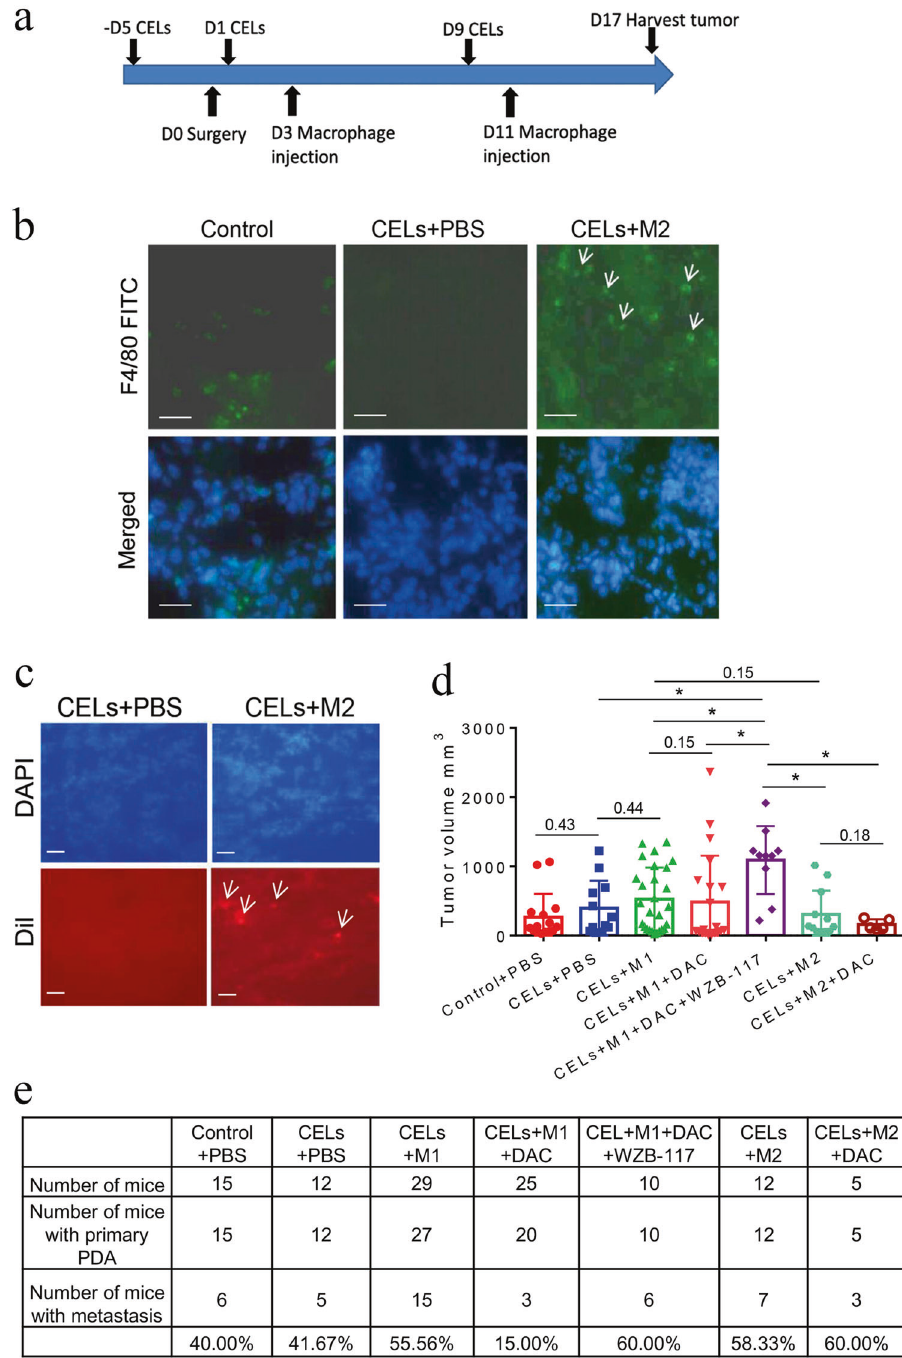
Fig. 5 Tumor-educated macrophages promote metastasis in the “ orthotopic ” mouse model of PDA in a DNA methylation-dependent manner. a Scheme of the experiment. The exogenous macrophages were isolated from eight C57BL/6 mice. b Pancreas tissues were stained with FITC- conjugated anti-F4/80 antibody to evaluate macrophage depletion and exogenous macrophage infusion. Representative treatment groups are shown. Arrow indicates F4/80-positive macrophages. Scale bar: 50 μ m. c Examination of exogenous macrophages pre-labeled by Vybrant Dil. Arrow indicates Vybrant Dil-positive macrophages in pancreas tissues. Scale bar: 50 μ m. d Average sizes of pancreatic tumors at the end of the experiments in mice of each treatment group as indicated. Data are means ± SEM from triplicates, * P < 0.05 (ANOVA). e Percentag e s of mice that had metastasis in each treatment group in ( d ). Primary tumors and metastases were examined both grossly and microscopically. Note that some primary tumors were not visualized grossly likely due to technical variations of tumor implantation. DAC + M1 vs. other CELs groups ( P = 0.002), DAC + M1 vs. DAC + WZB-117 + M1 ( P = 0.03). CELs + M1 vs. CELs + M2 ( P = 0.65). All used Fisher ’ s exact tests